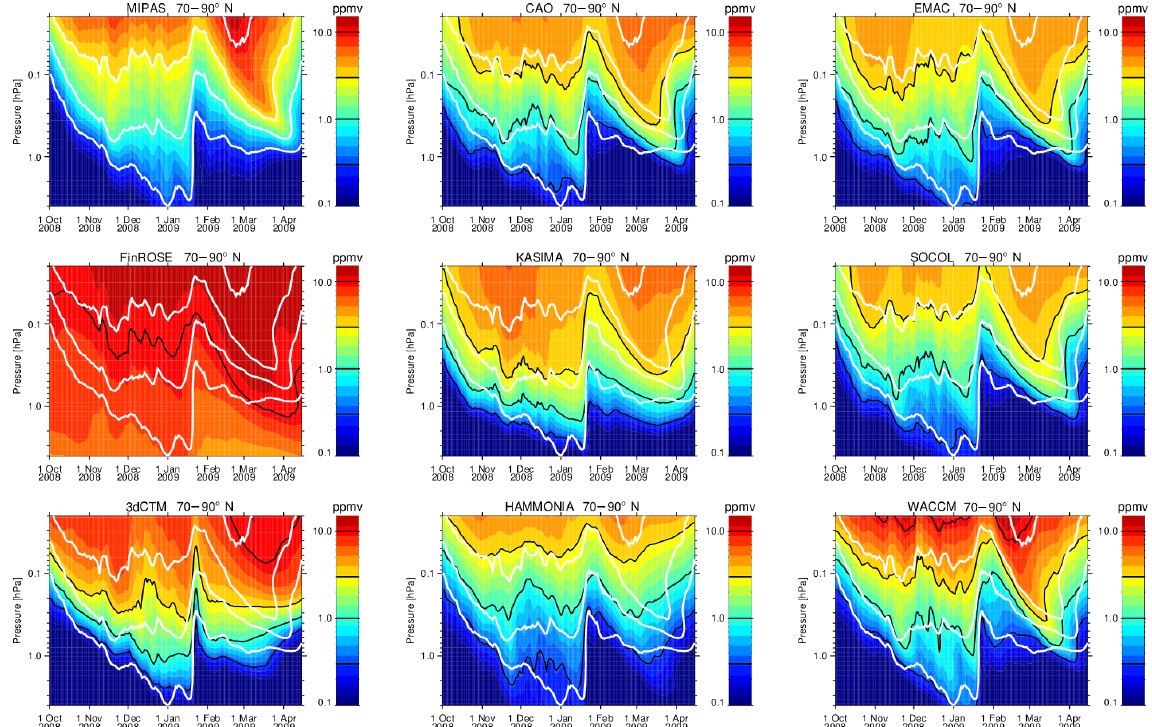
Figure 9. MIPAS-NOM and modeled temporal evolutions of CO at 4–0.02hPa within 70–90 ◦ N. White lines indicate the observed VMR levels of 0.3, 1, 3, and 10ppmv.